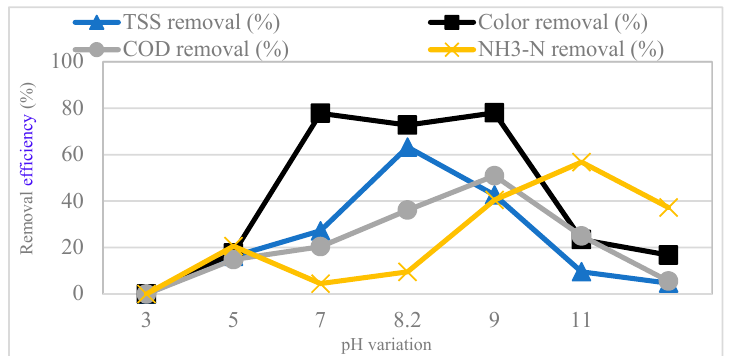
Figure 3. Effect of pH variation on COD, Color, TSS and NH 3 –N removal using a tannin dosage of 0.75 g at 250 rpm for15 min, 60 rpm for 30 min and after 30 min settling.